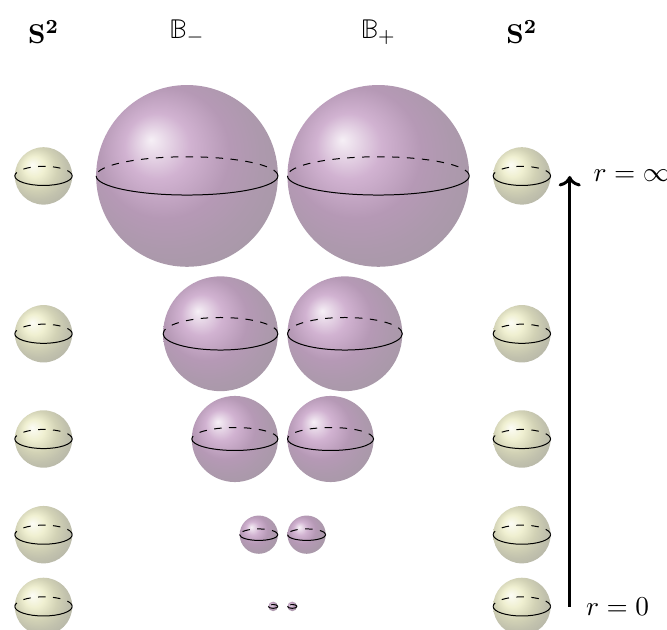
Figure 10 . The resolved conifold is described as a collection of S 3 s placed along an in(cid:12)nite ray with the coordinate r 2 [0 ; 1 ). At each point along the ray we have a (cid:12)ve-dimensional space S 3 (cid:2) S 2 , with the S 3 having radius r and the S 2 being of unit radius. In our illustration, we have decomposed the S 3 topologically into two 3-balls B (cid:0) and B + (which are assumed to be identi(cid:12)ed along their boundaries). The purpose of the S 2 ’s drawn alongside each 3-ball is to remind us that each point in the S 3 carries with it a S 2 of unit radius, and as explained in footnote 8 we are leaving implicit the (cid:12)bration